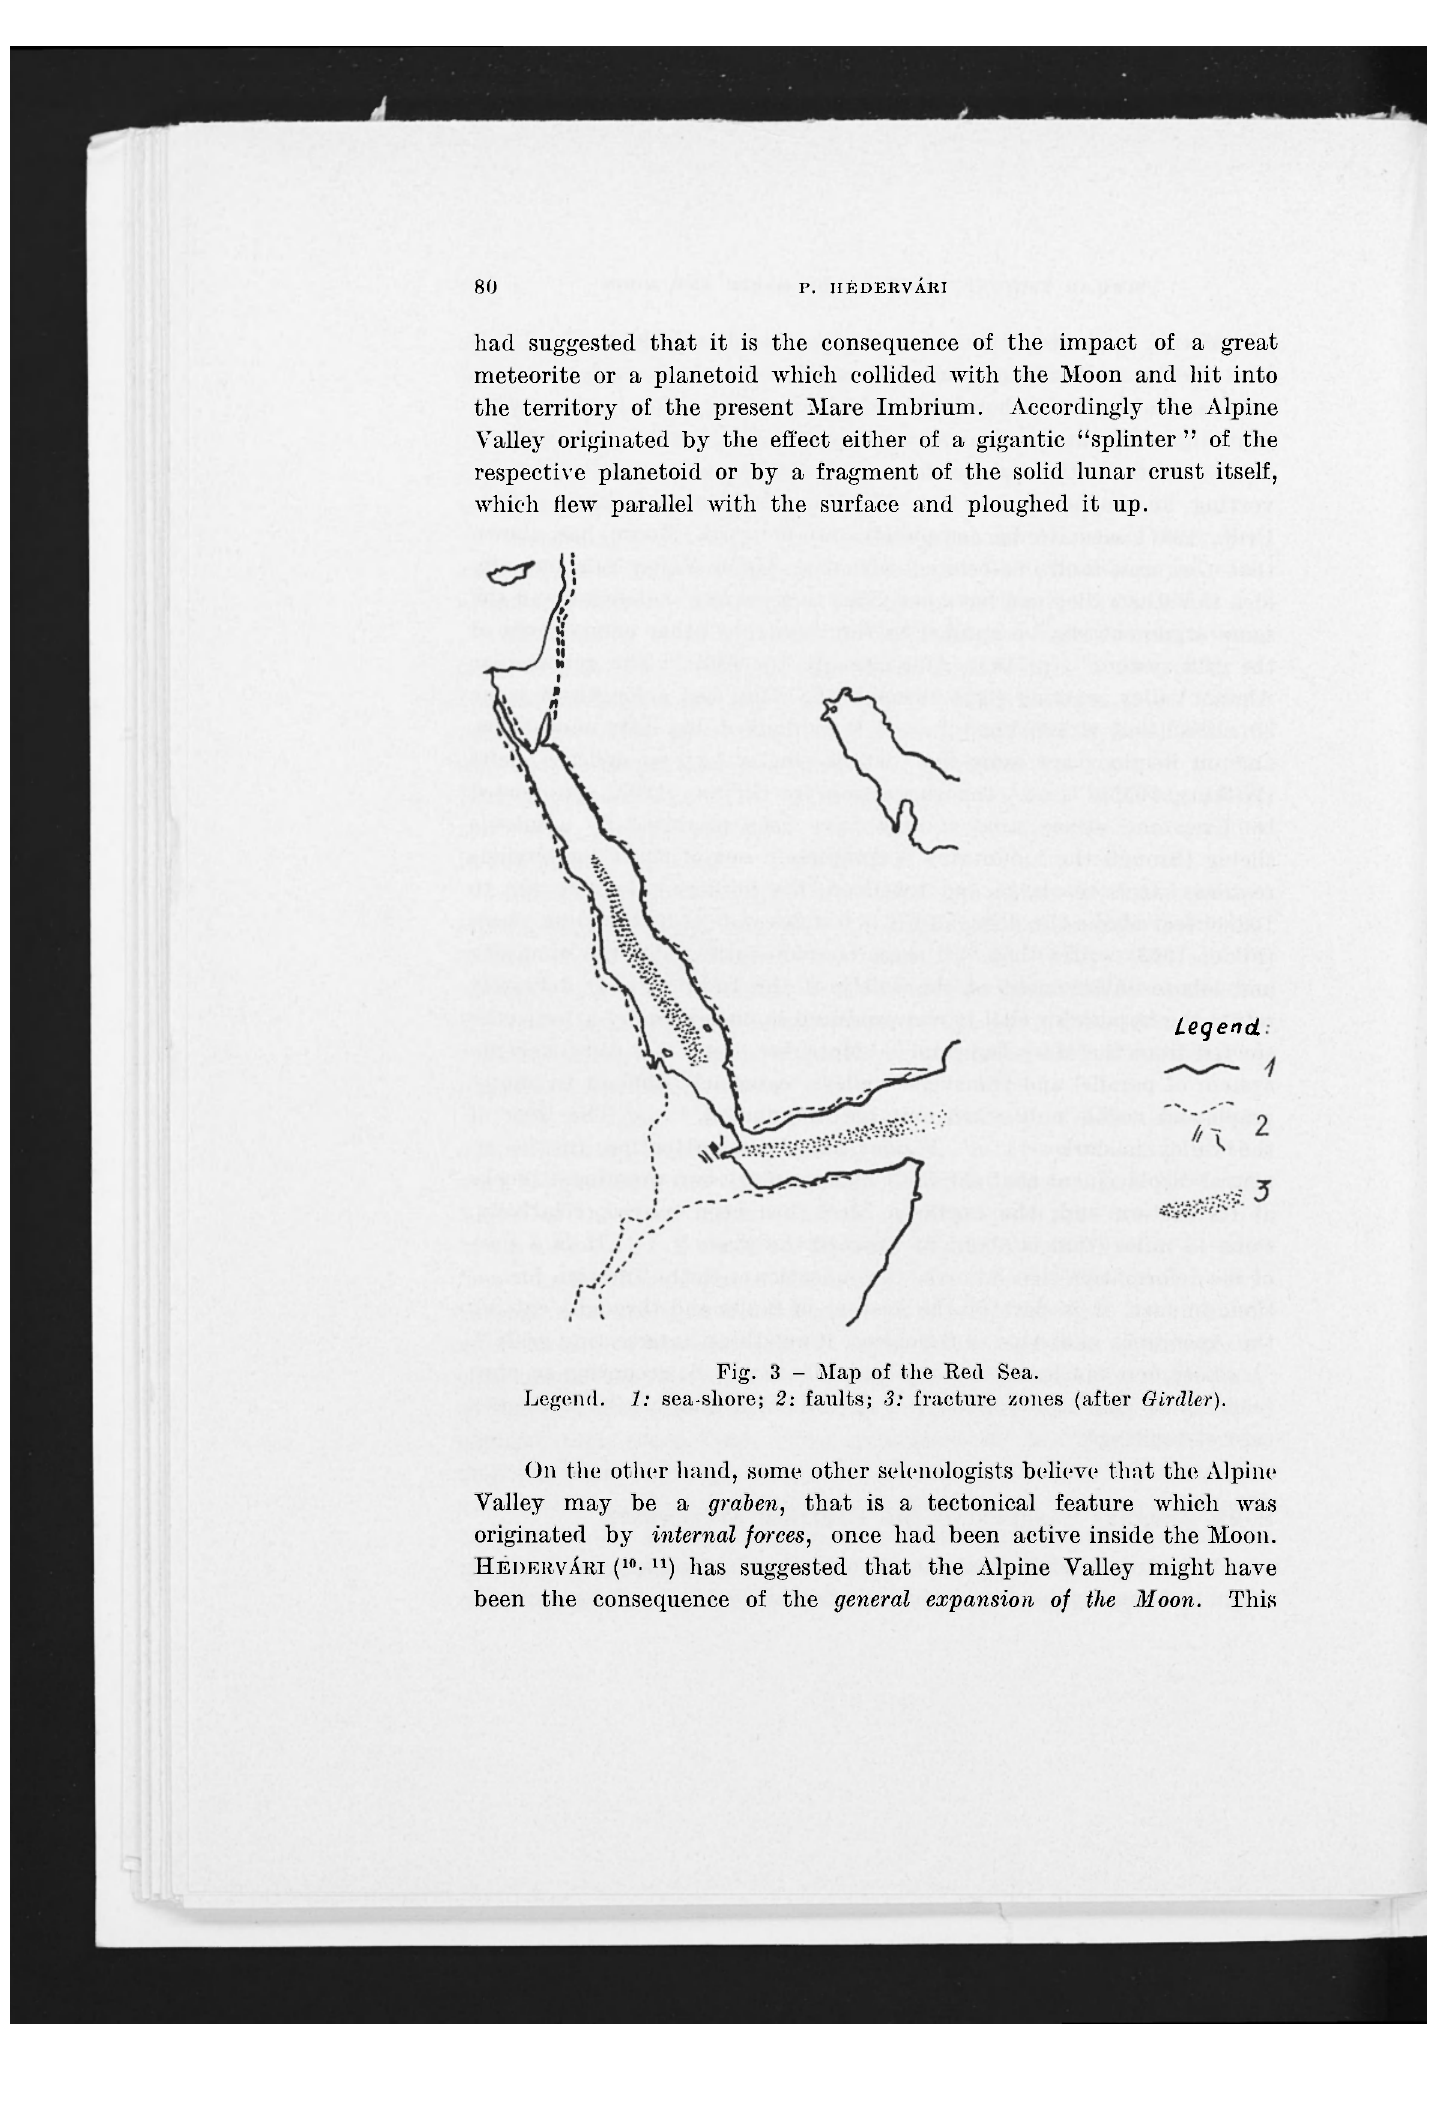
Fig. 3 - Map of the Red